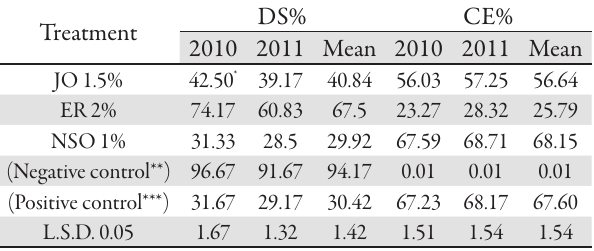
Tab. 4. Efficacy of tested plant derived agents against